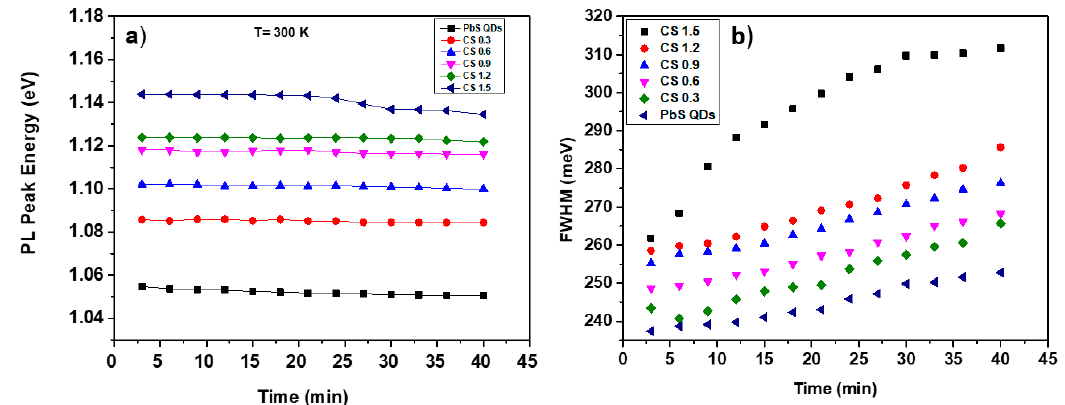
Figure 6. ( a ) Graph of PL peak energies over time exposure to the laser, p = 100 mW. ( b ) Dependence of full width half maximum (FWHM) of the CS 1.5 PL spectrum on the irradiation time.